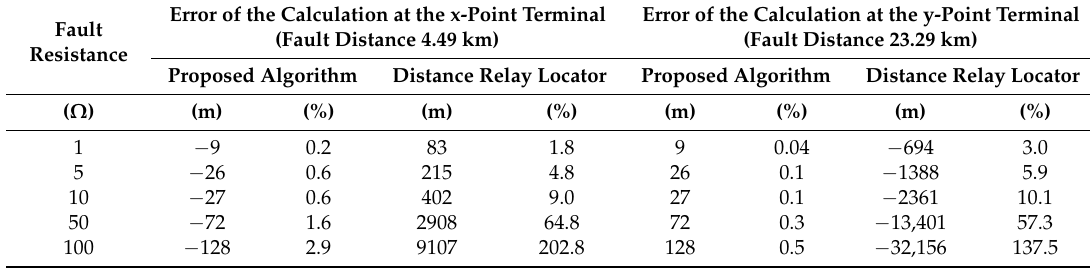
Table 2. Testing the impact of the fault resistance. Fault